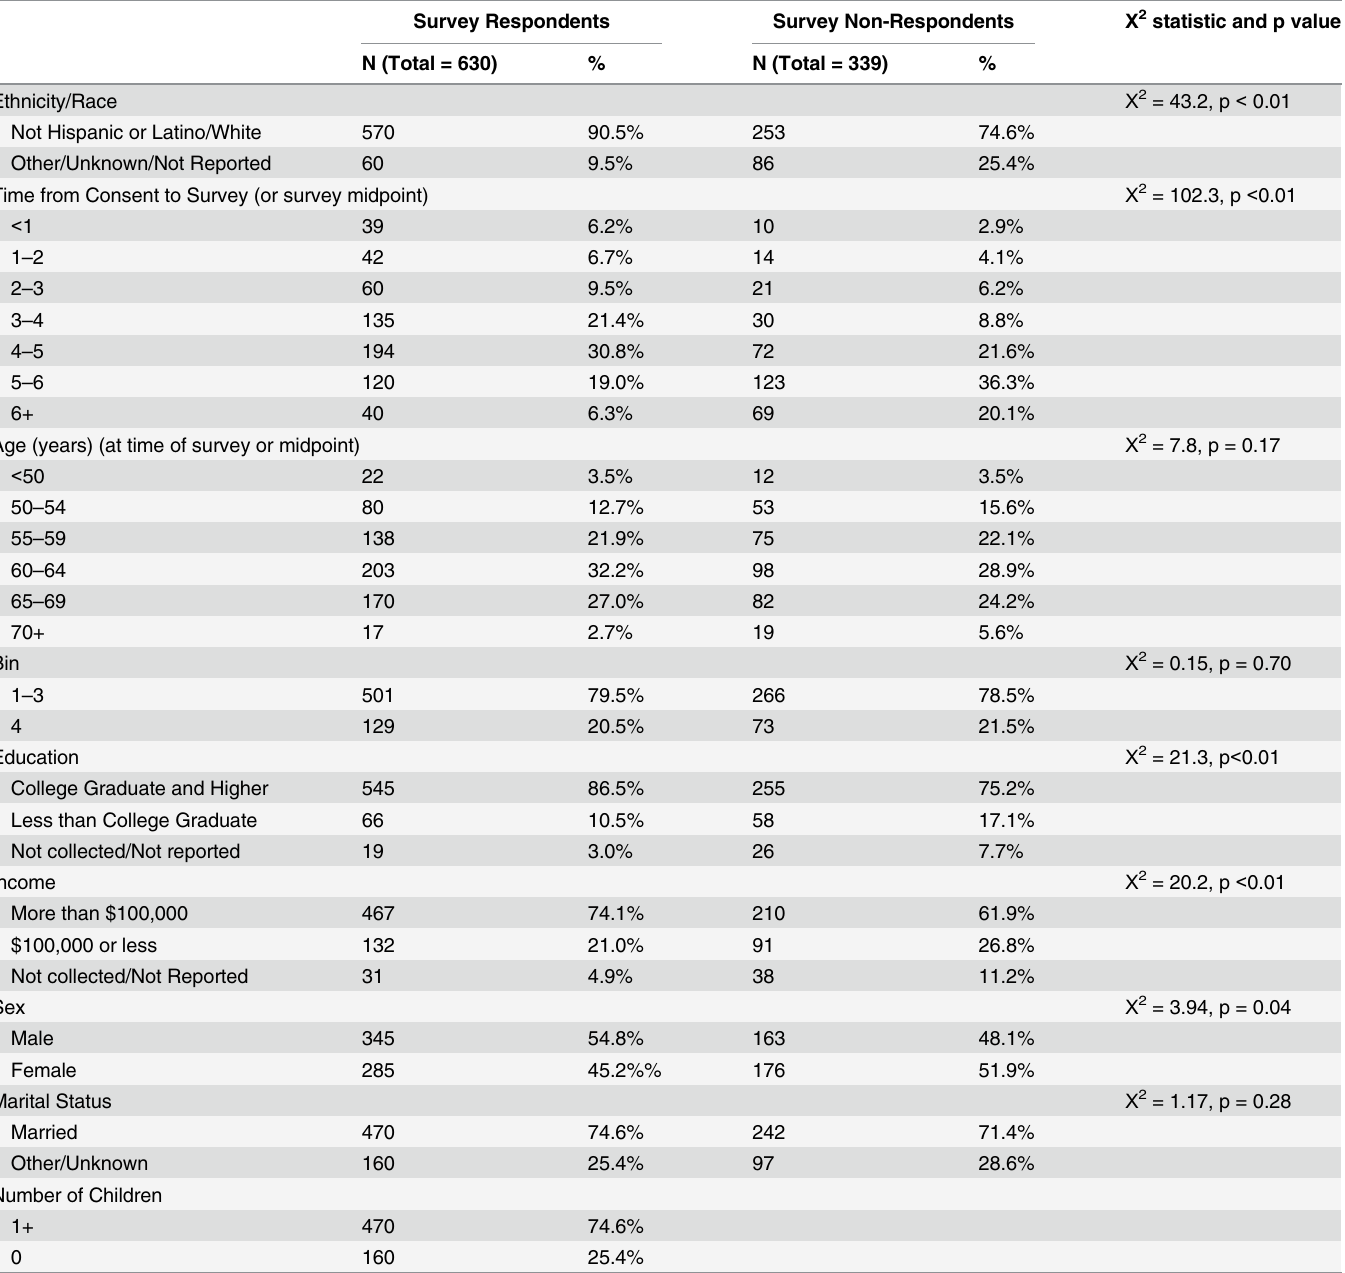
Table 1. Demographics of Respondents versus All